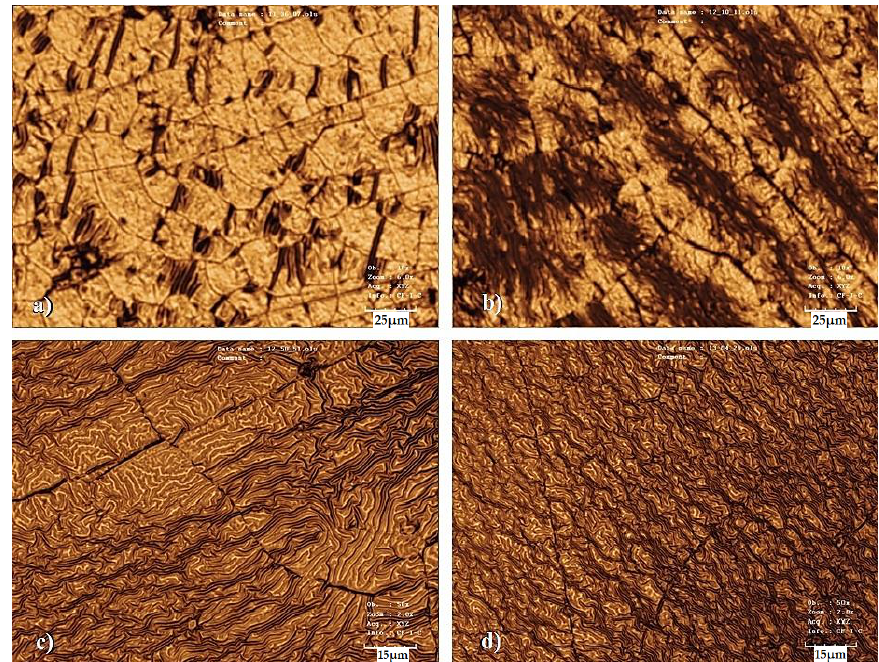
Figure 2. Surface morphology of heated PLLA samples with sputtered Au and Ti layers. The images were taken by a laser confocal microscope. ( a ) Au and Ti layers of 2 and 28 nm, respectively; ( b ) Au and Ti layers of 5 and 25 nm, respectively; ( c ) Au and Ti layers of 10 and 20 nm, respectively; ( d ) Au and Ti layers of 25 and 5 nm, respectively.